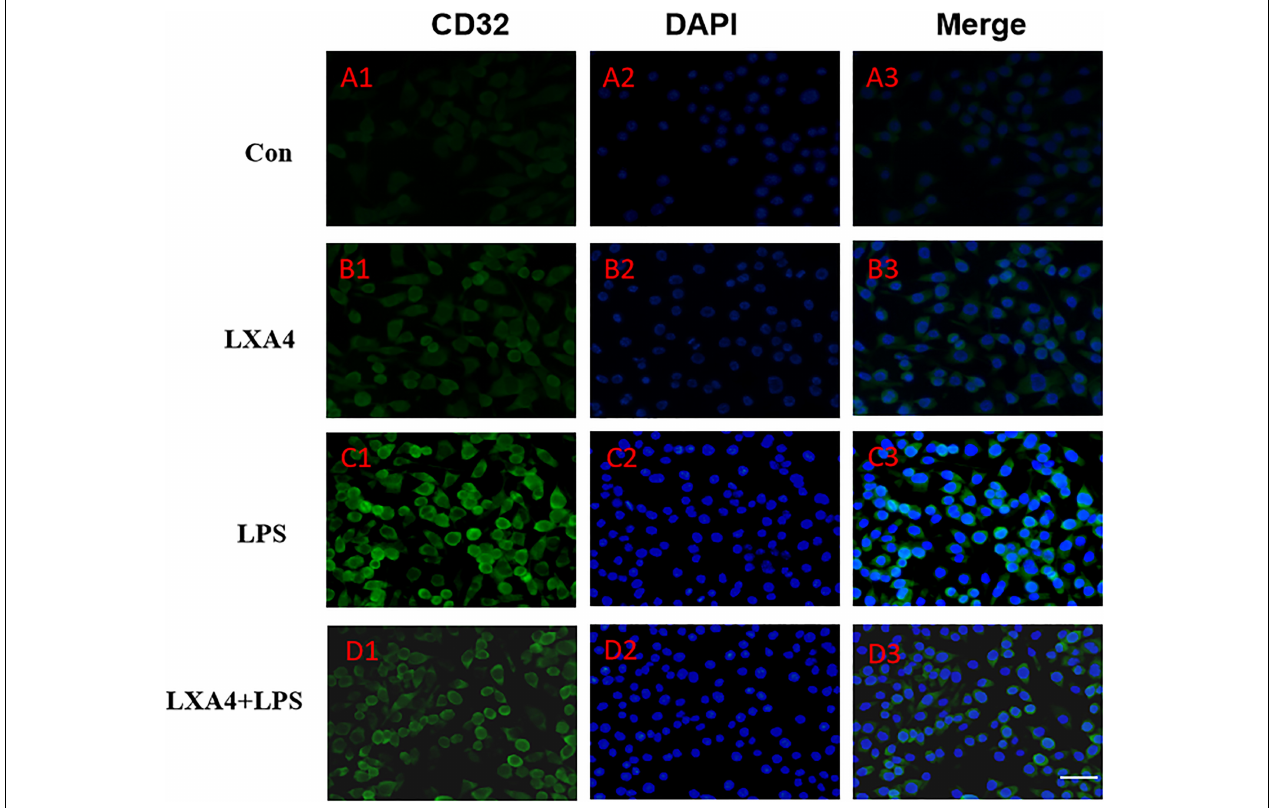
FIGURE 5 | Immunofluorescence images showing the BV2 microglia after LPS stimulates which were labeled with CD32 antibody, with LXA4, the expression of iNOS is decreased. Green fluorescence indicated CD32 positive cells, while blue fluorescence indicated DAPI-labeled nuclei. Scale bar: 20 µ m.